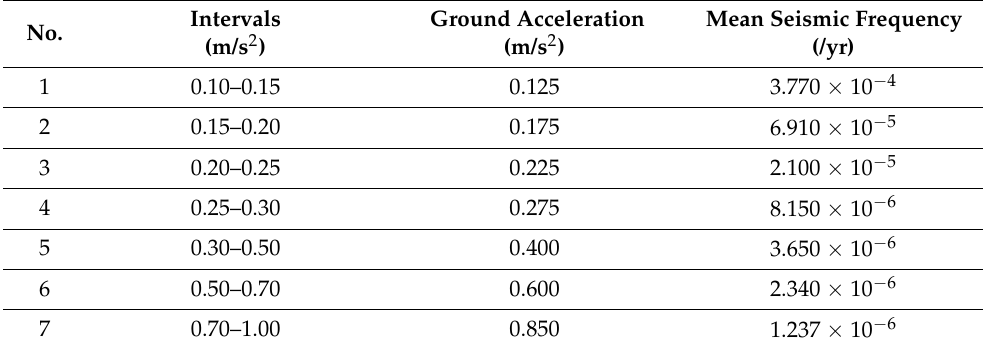
Table 5. Ground acceleration